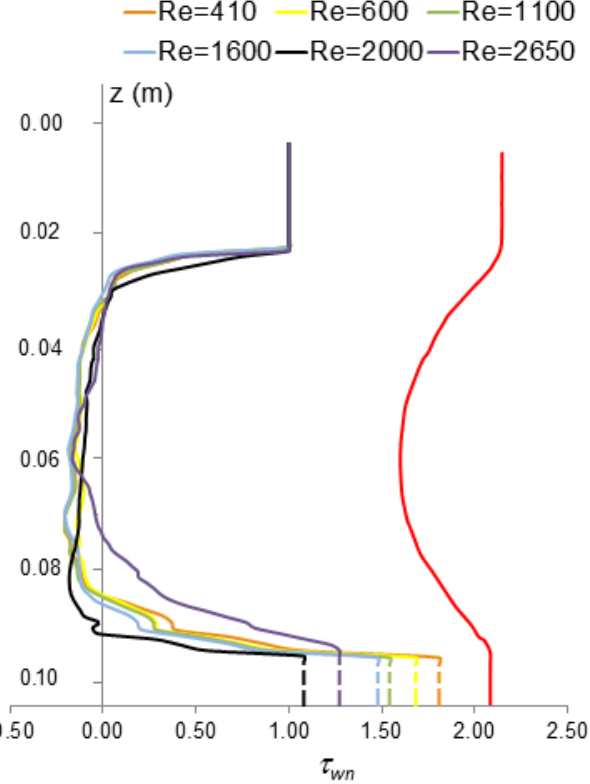
Figure 6. Normalized wall shear stress (WSS) τ wn for varying Re . The red line represents the left aorta boundary. Data are from the second set of experiments (ID 1’ to 6’, Table 1).